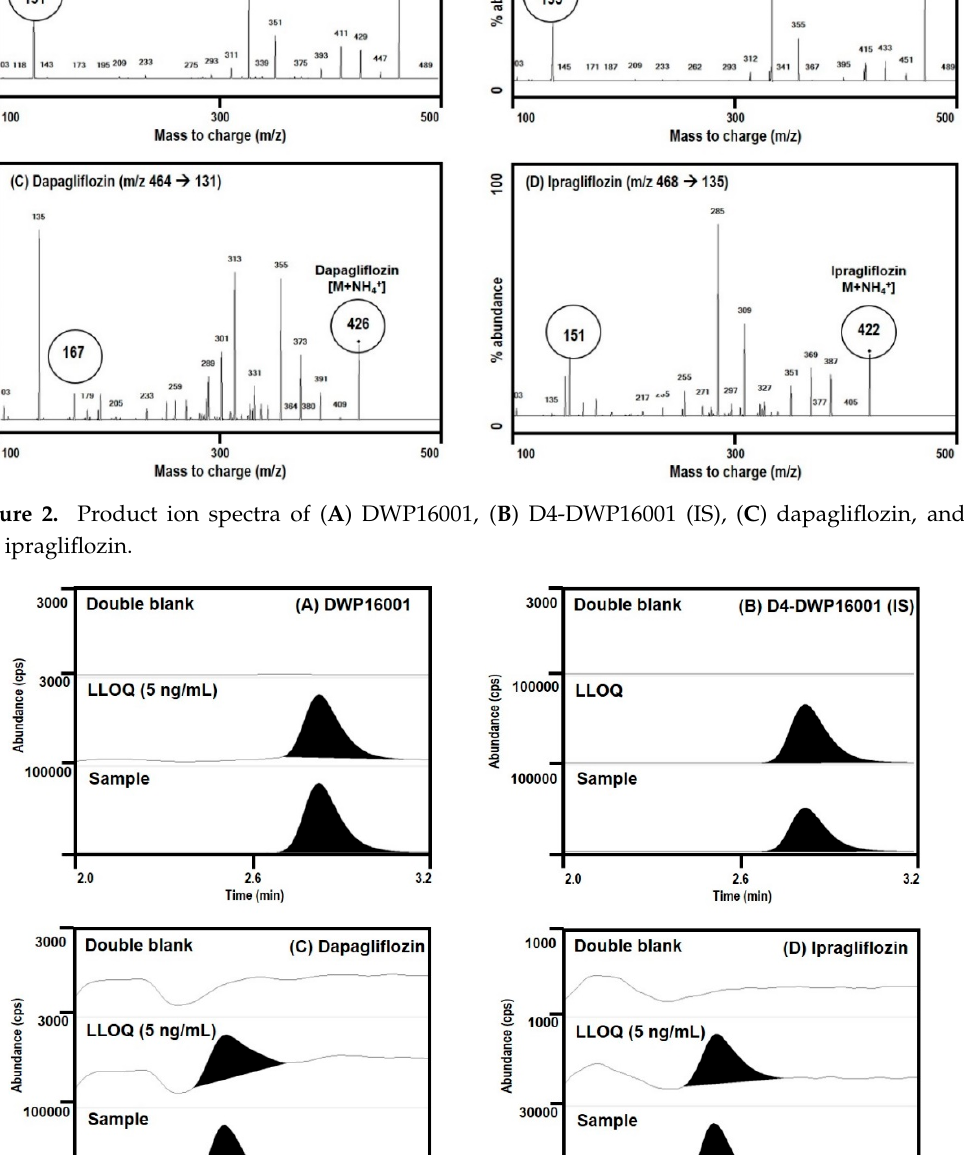
Figure 3. Representative multiple reaction-monitoring (MRM) chromatograms of ( A ) DWP16001, ( B ) D4-DWP16001 (IS), ( C ) dapagliflozin, and ( D ) ipragliflozin in mouse double-blank plasma, blank plasma spiked with DWP16001, dapagliflozin, ipragliflozin at the lower limit of quantification (LLOQ) (5 ng/mL), and plasma samples at 1 h following single oral administration of DWP16001, dapagliflozin, or ipragliflozin at a dose of 1 mg/kg.